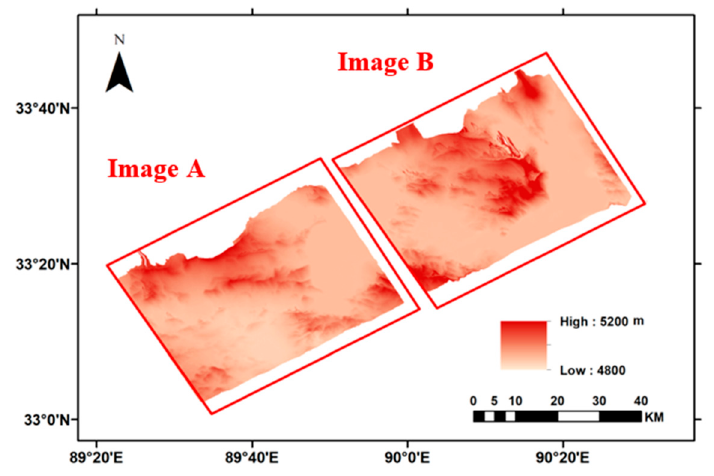
Figure 2. The elevation of the study region estimated by InIRA.